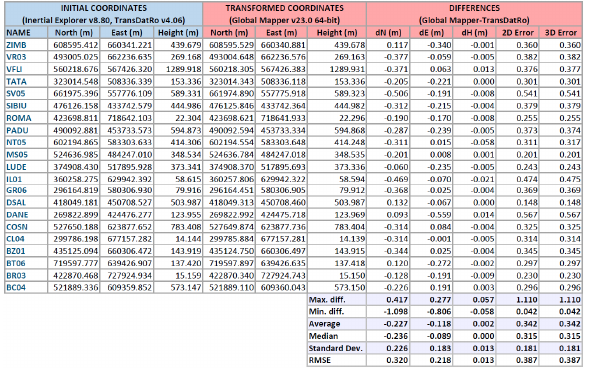
Table 3 . Transformation results with Global Mapper v23.0